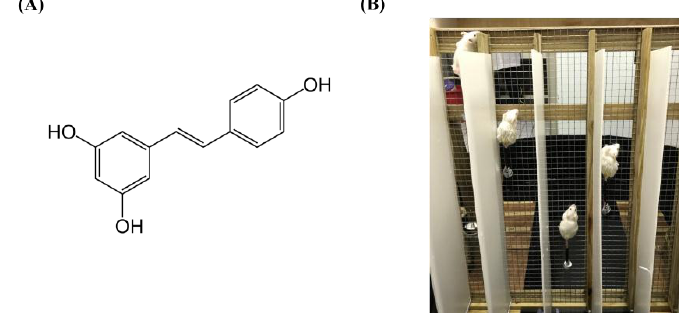
Figure 1. The structure of resveratrol ( A ) and the climbing device ( B ) for resistance training.